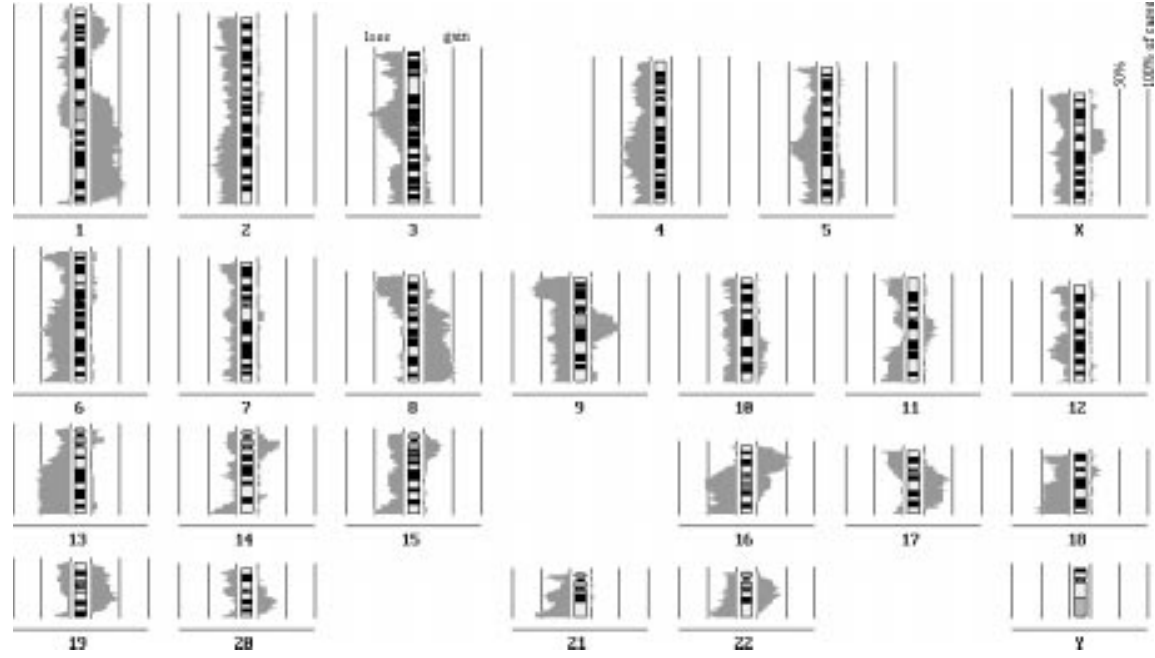
Fig. 5. Histogram of the CGH result of 18 peritetraploid breast cancers shown by gray areas besides the chromosome ideograms. Significance level of 95% for gains or losses in the Student’s t